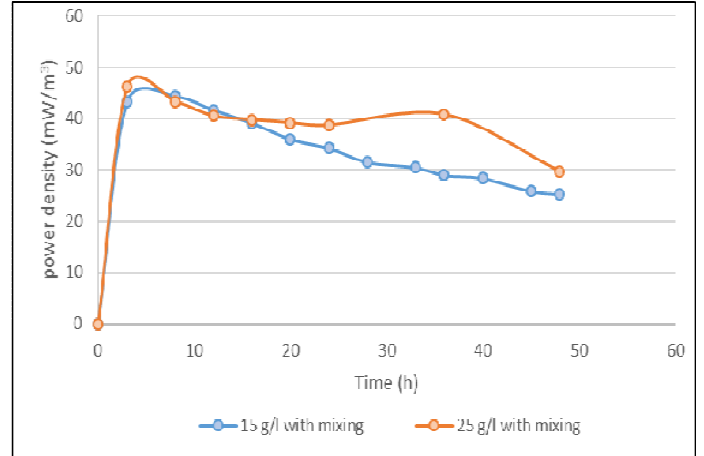
Fig. 2 show the performance of the MDC with 50 K Ω of the external resistance and with 25-15 g/L of NaCl in desalination chamber with continuous pure O2.